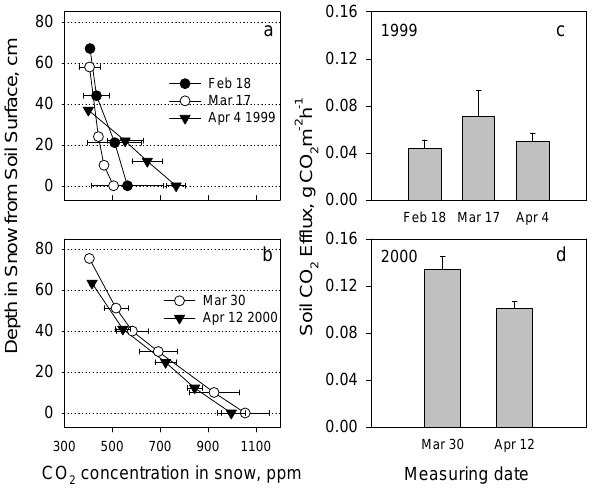
Fig. 3. (a, b) Concentration of CO 2 in snow (s.e. as error bars, n = 2 − 4). The top-most symbols represent average concentration in the top 2cm of snow. (c, d) Soil CO 2 efflux in winter in 1999 ( c) and 2000 ( d), standard error bars presenting variation between two plots measured, n = 3 per